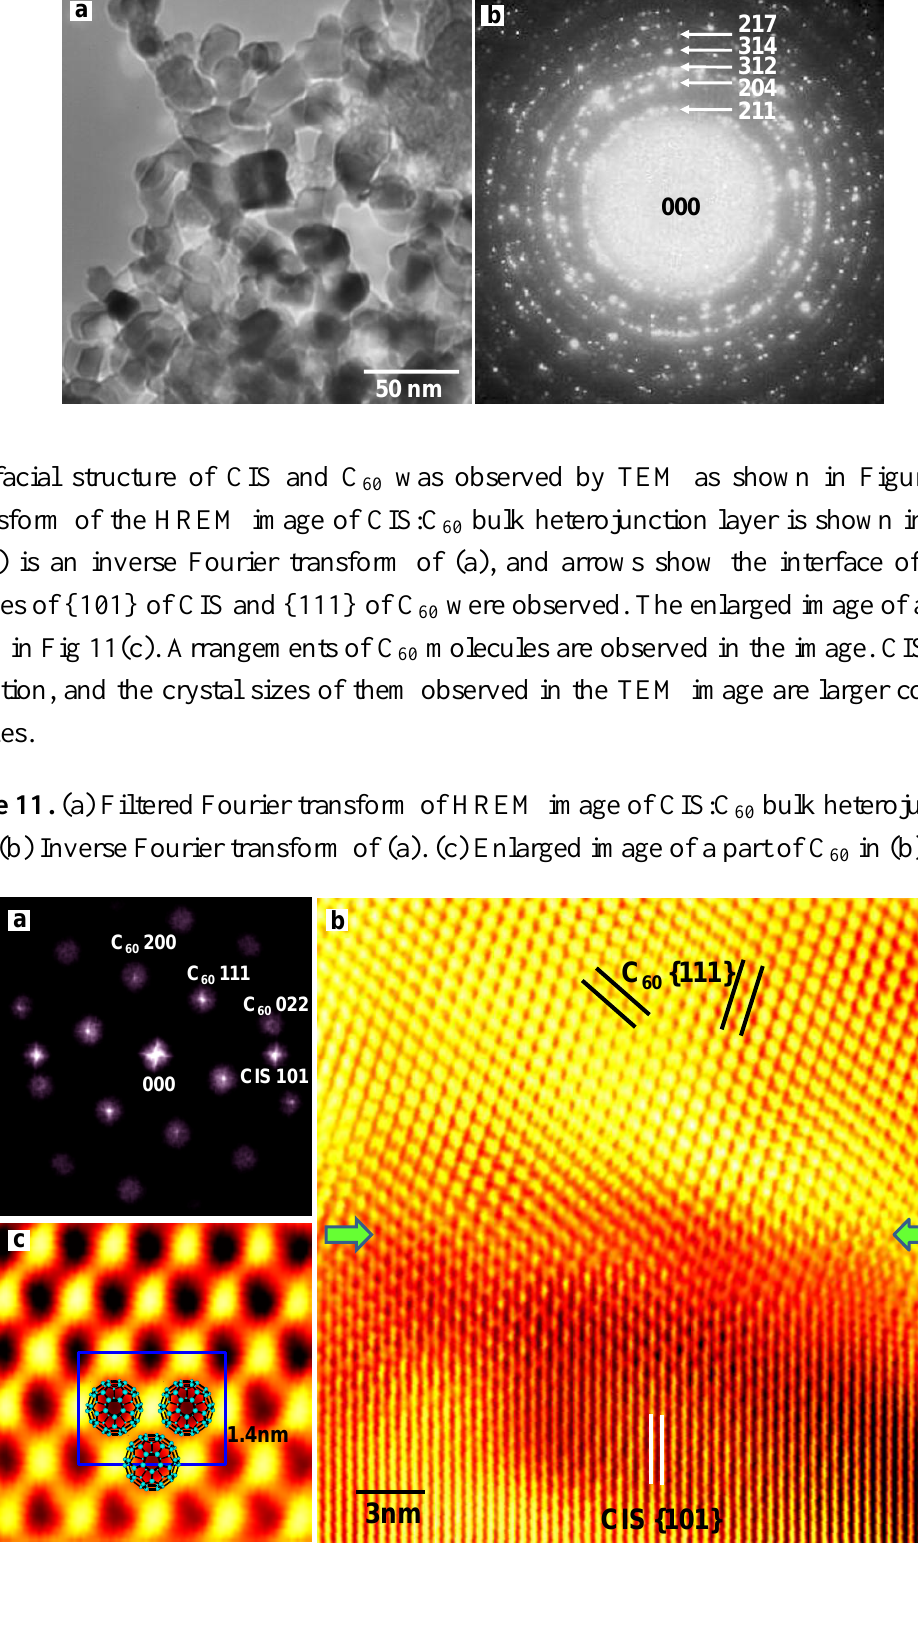
Figure 10. X-ray diffraction pattern of CIS:C